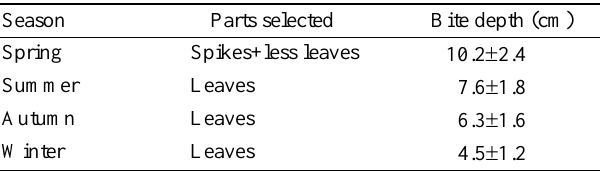
Table 1. The L. chinensis parts and bite depth selected by grazing cashmere